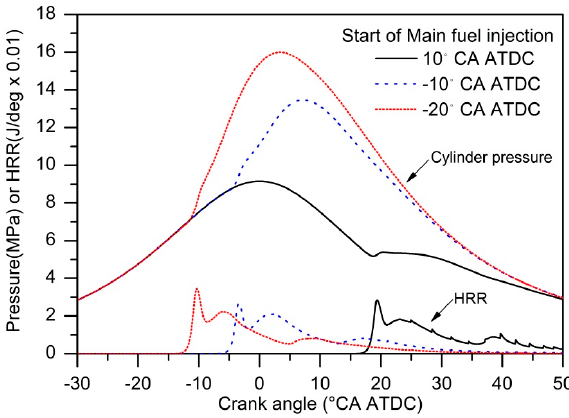
Figure 13. Comparisons of in-cylinder pressure and heat release rate versus crank angle under the cases of assigned EGR stratification with different start time of main fuel injection.